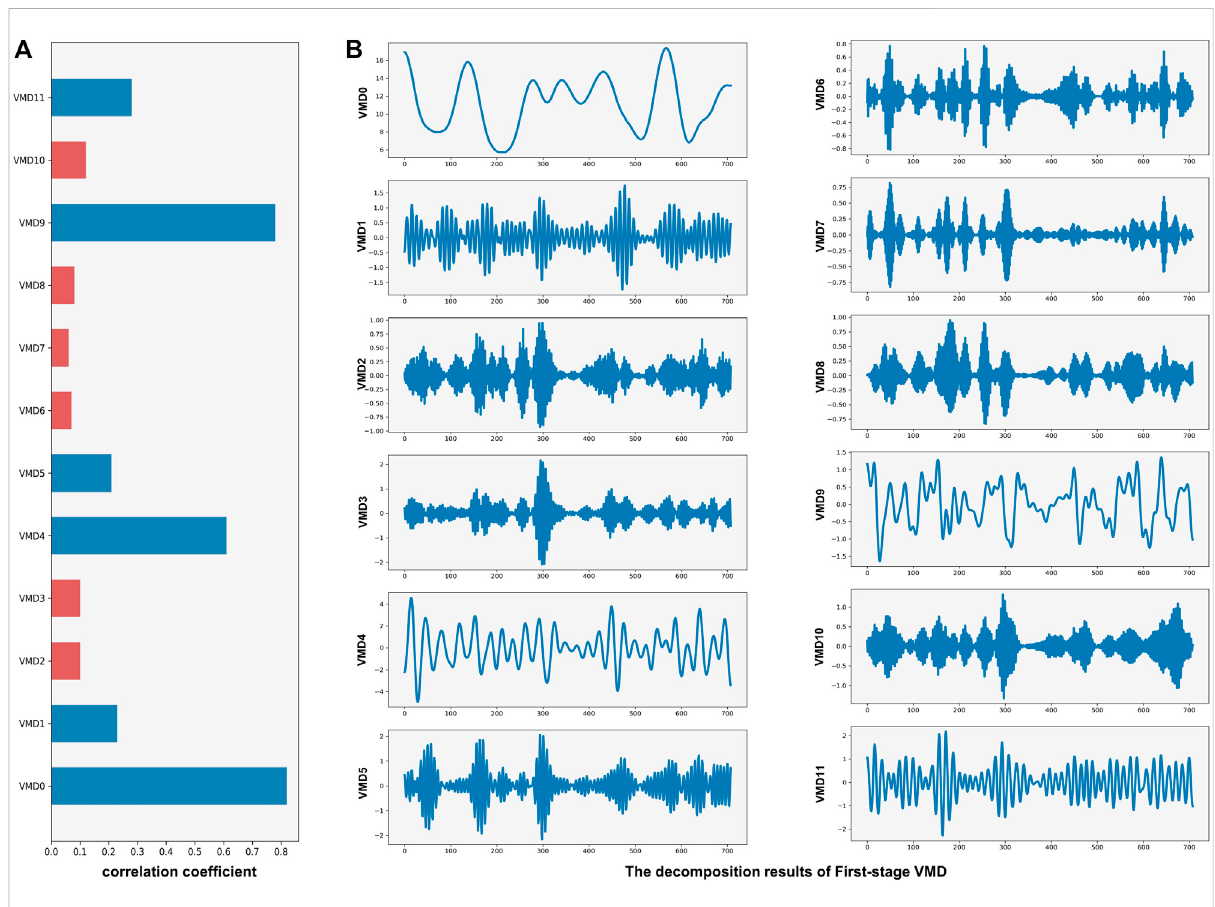
FIGURE 2 First-stage VMD results and correlation coef fi cients of period 1. The correlation coef fi cients between the observed time series and the decomposed Components (A) , the results of the fi rst stage VMD (B) .